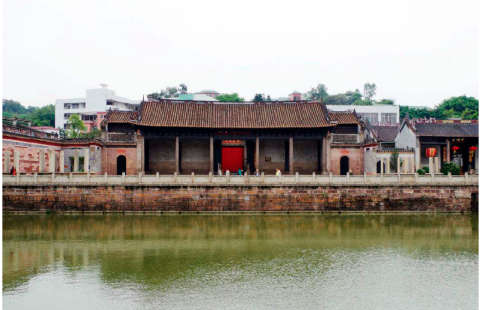
Figure 9. Liugengtang Square. (Source: the authors).